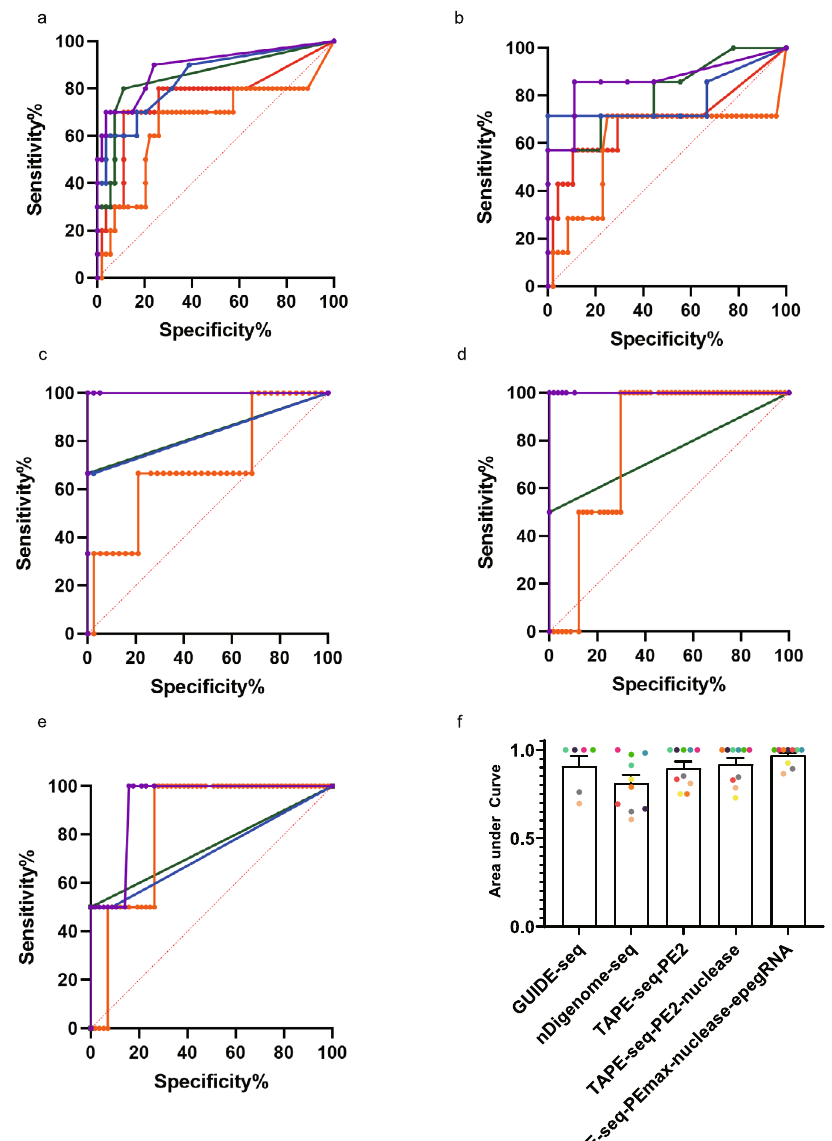
pegRNAs. g – k Venn diagrams showing the number of and overlap between off- target loci predicted by TAPE-seq using PEmax-nuclease with epegRNAs, GUIDE- seq, and nDigenome-seq and validated off-target sites for the g HEK4 (+2G to T), h HEK4 (+3TAAins), i HBB (+4AtoT), j DNMT1 (+6GtoC),and k VEGFA (+5GtoT) pegRNAs. l Miss rates of the fi ve different off-target prediction methods ( n =6 independent experiments for GUIDE-seq and n =10 independent experiments for therestofthemethodseachrepresentedbydifferentcolor).Thebarsrepresentthe mean. Error bars indicate standard deviation.